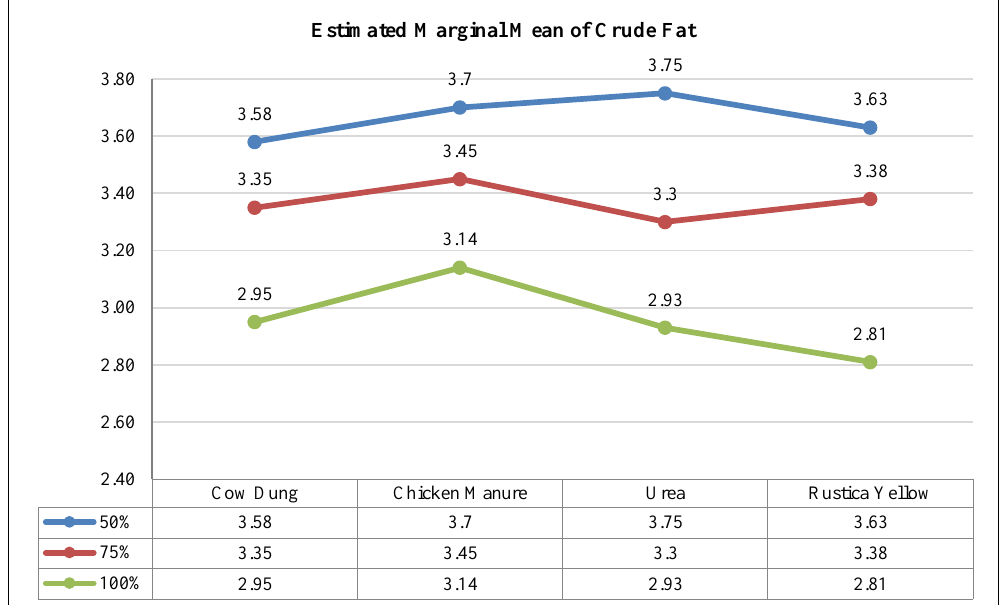
Figure 10. Nitrogen Sources Effects and Levels on Crude Fat of King Grass ( Pennisetum Purpureophoides